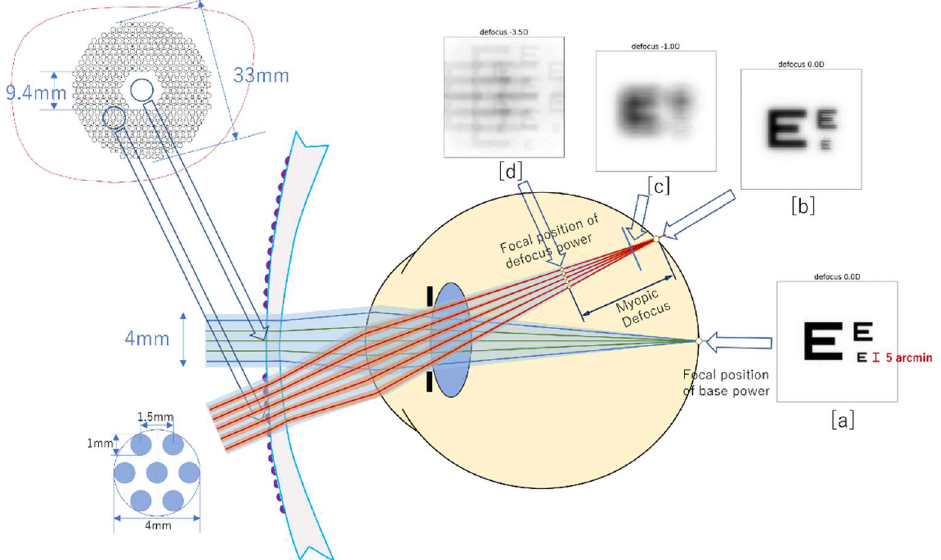
Figure 2. Optical principles of DIMS lens. The blue lines represent ray traces from the central (carrier) part of the lens, which form a clear image on the retina [ a ], while the red lines represent ray traces from the peripheral part of the lens, containing the lenslets, which form an image that is refracted by both the base part and the lenslets simultaneously [ b ]. The picture [ c ] or [ d ] will be generated on the retina if the target is close and the eye does not accommodate. An object located on the central axis generates a crisp image with no ghosting, while seeing a target via the peripheral section of the lens causes ghosting, depending on the relative refractive error at the retina as described in [ c ] or [ d ]. [Image taken from Lam et al. “Effect of Defocus Incorporated Multiple Segments Spectacle LensWear on Visual Function in Myopic Chinese Children”]